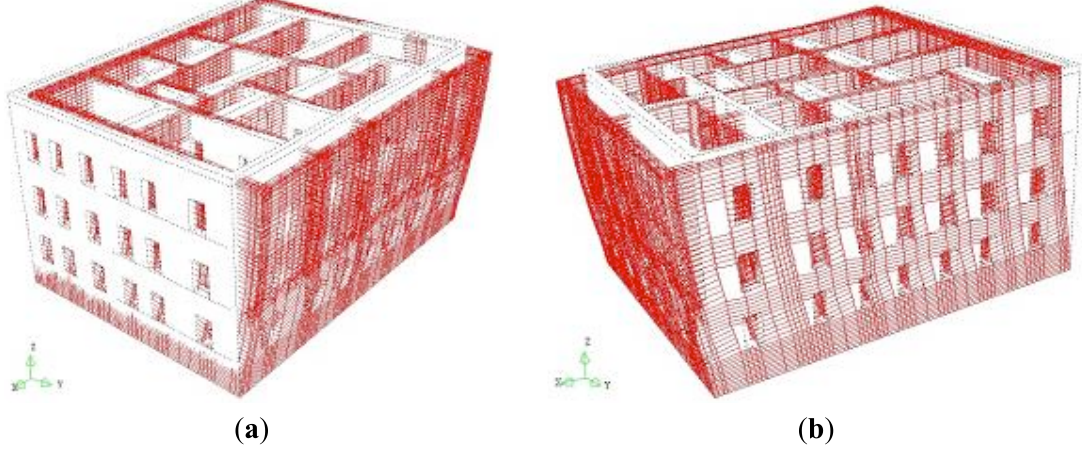
Figure 8. Modal shapes given by the 3D model for the building with the underground